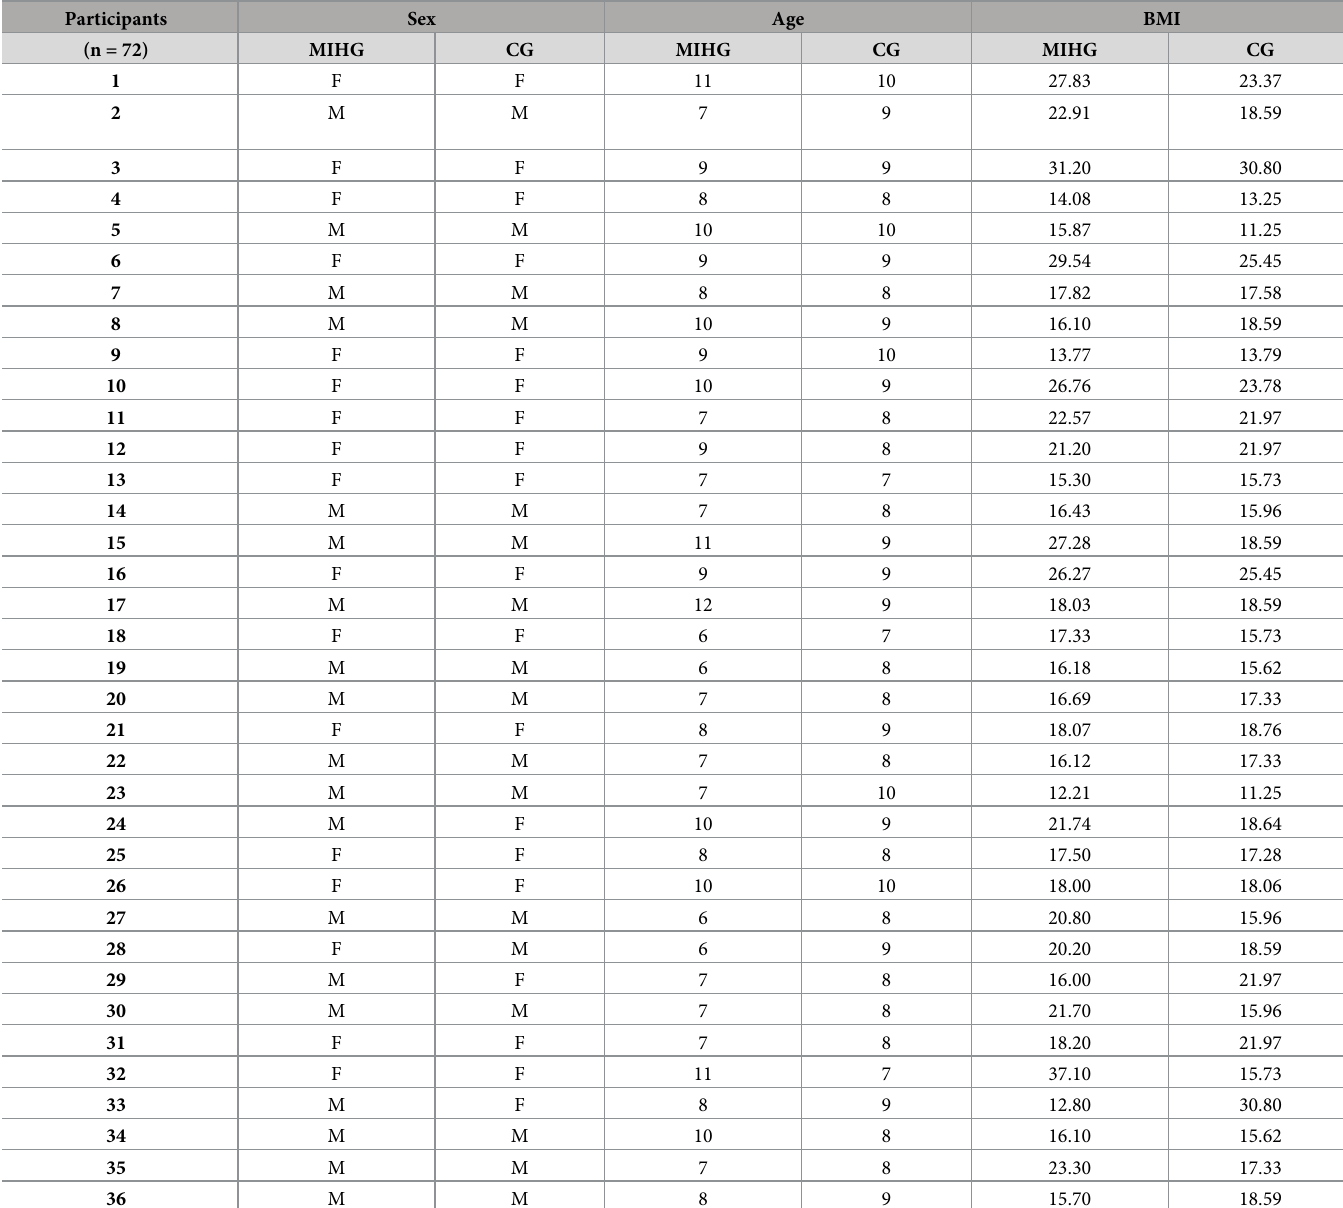
Table 2. Subject-to-subject matching of the MIH group (MIHG) and the control group (CG).